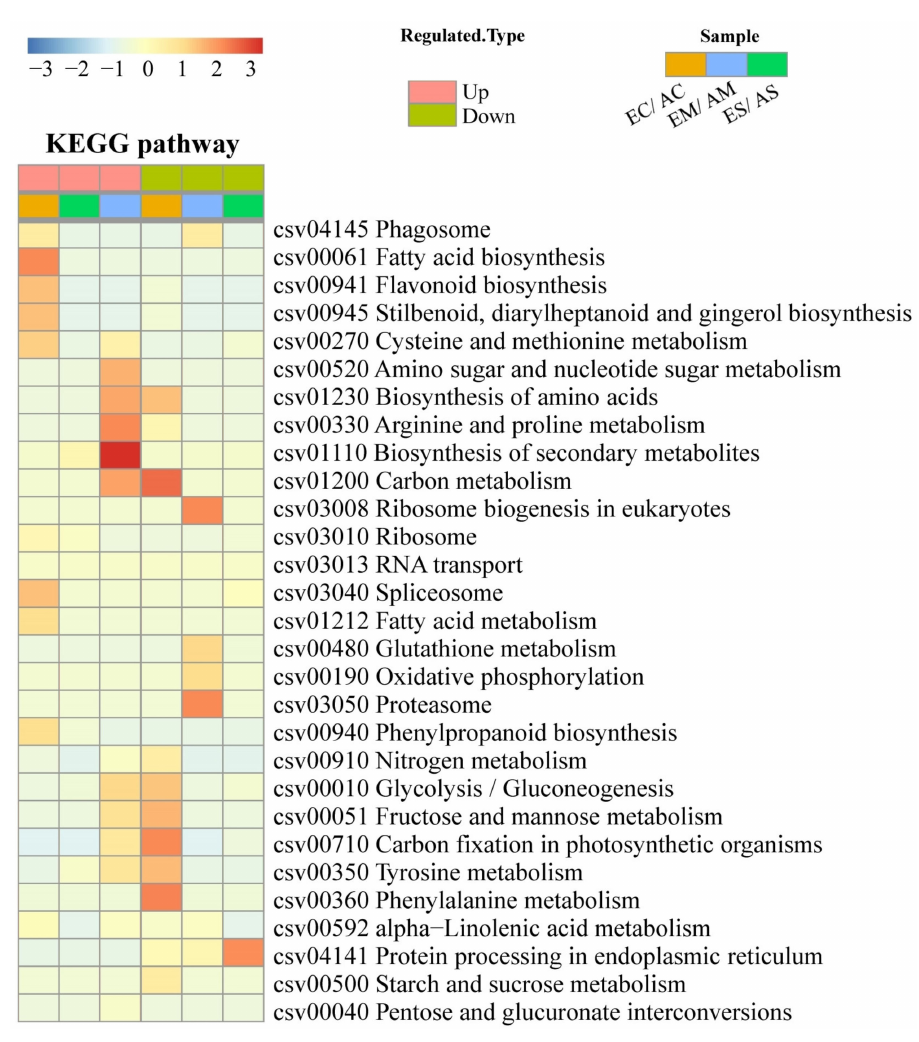
Figure 3. Cluster analysis of the enrichment patterns of KEGG pathways of differential accumulating proteins under [CO 2 ] enrichment. The color blocks corresponding to the functional description of the differentially expressed proteins in different groups indicate the degree of enrichment; red represents strong enrichment and blue represents weak enrichment.